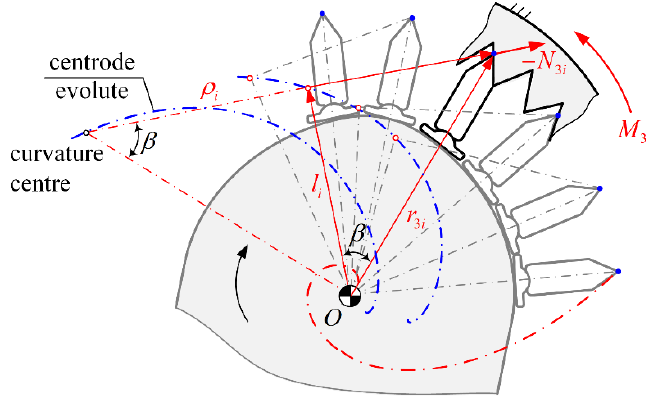
Figure 9. Arm of contact force of each tooth.